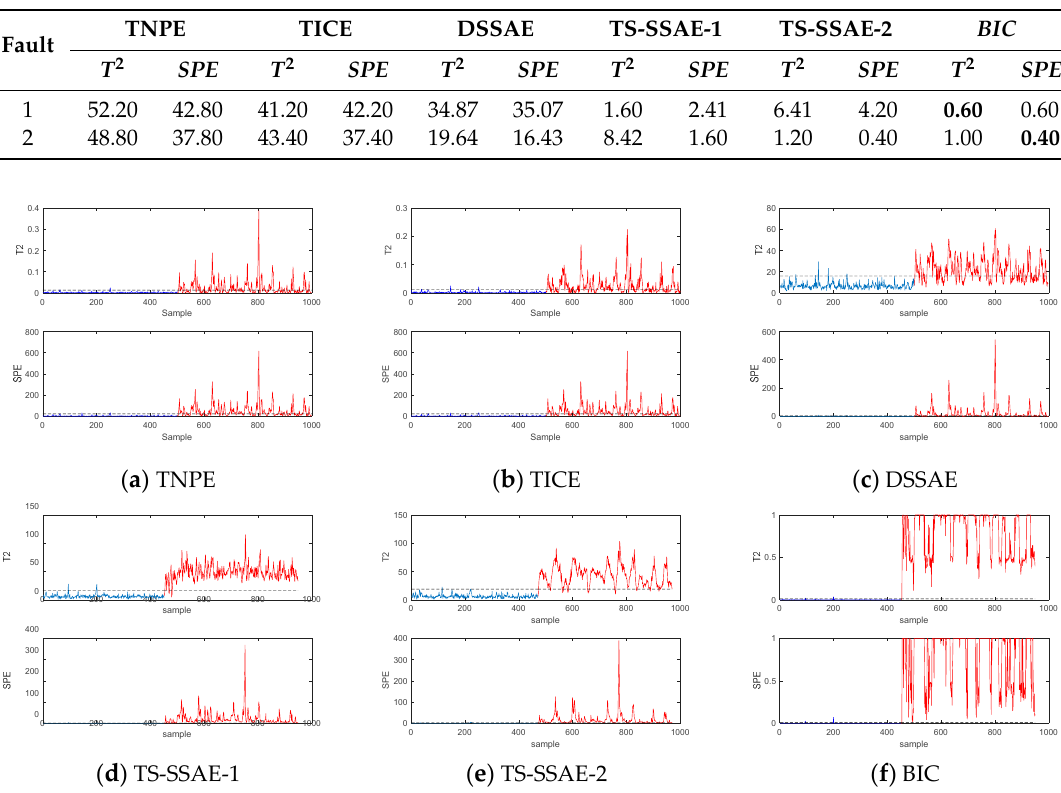
Table 2. Result of fault detection in the case study (missing alarm rate (MAR)) / %.